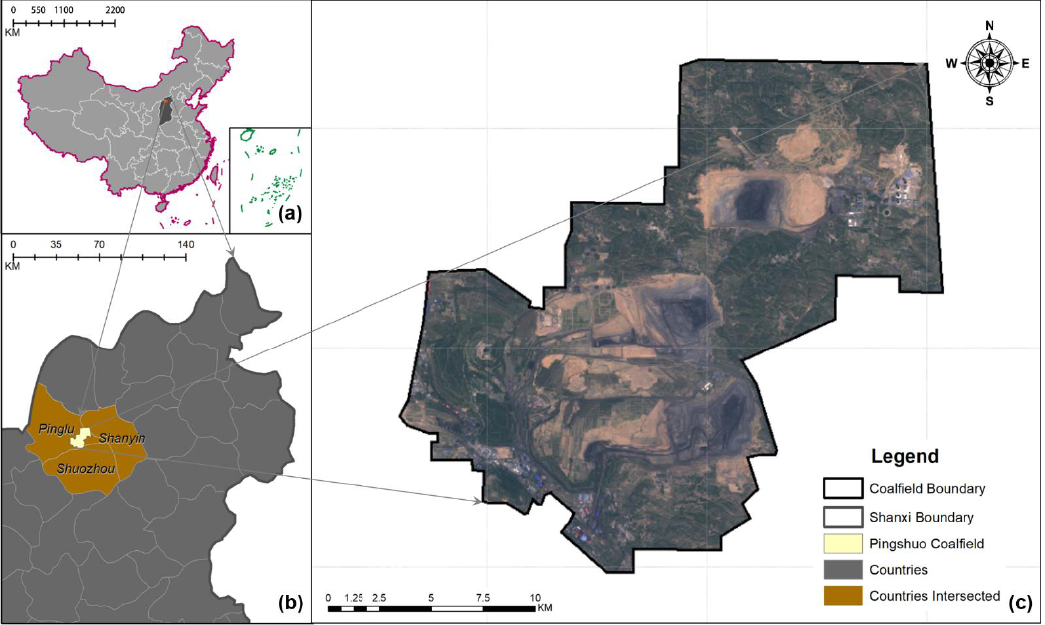
Figure 1. Location of the study area. ( a ) china, ( b ) shanxi province, ( c ) pingshuo coal field.